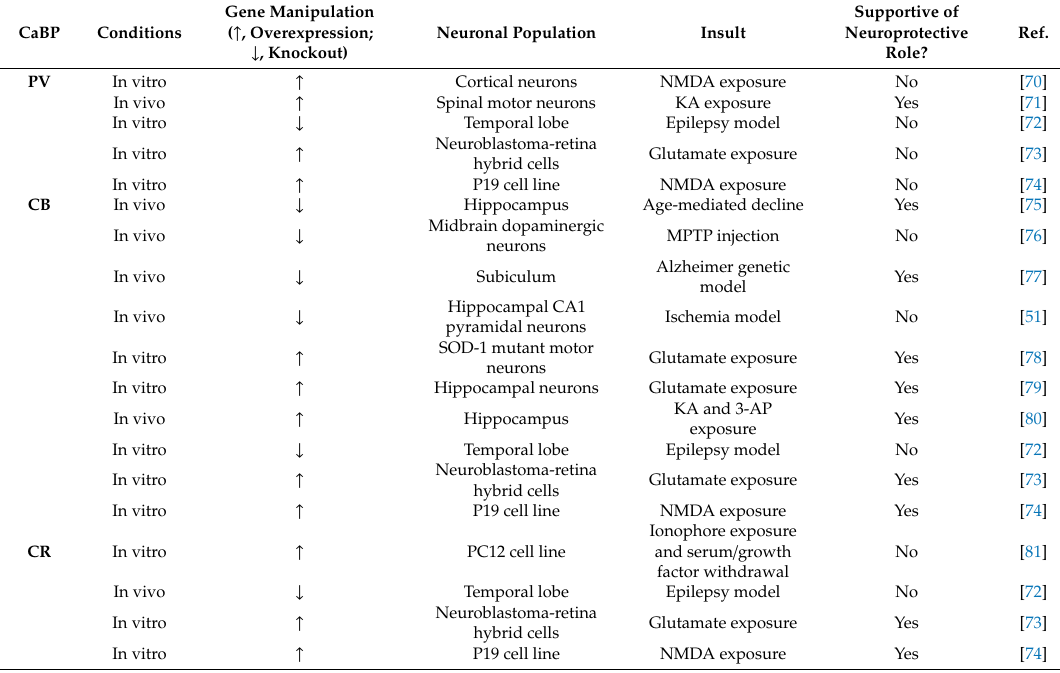
Table 3. CaBP modulation through overexpression or knockout under in vivo and in vitro